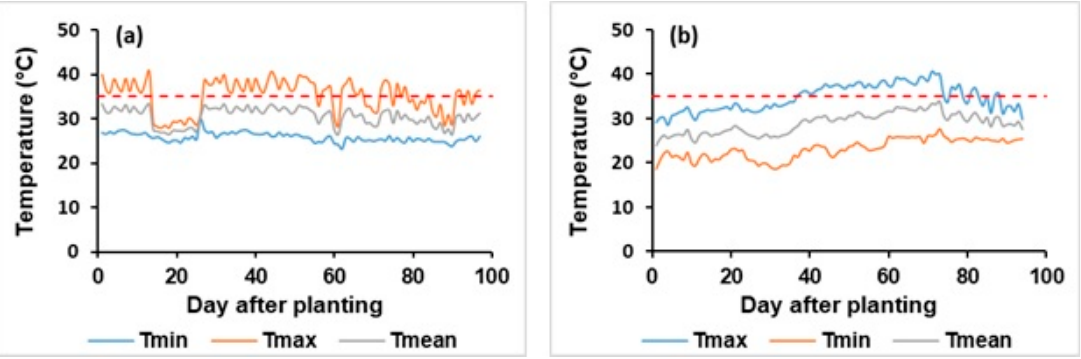
Figure 6. Daily temperature for Summer–Autumn season 2020 ( a ) and Spring–Winter season 2021 ( b ).